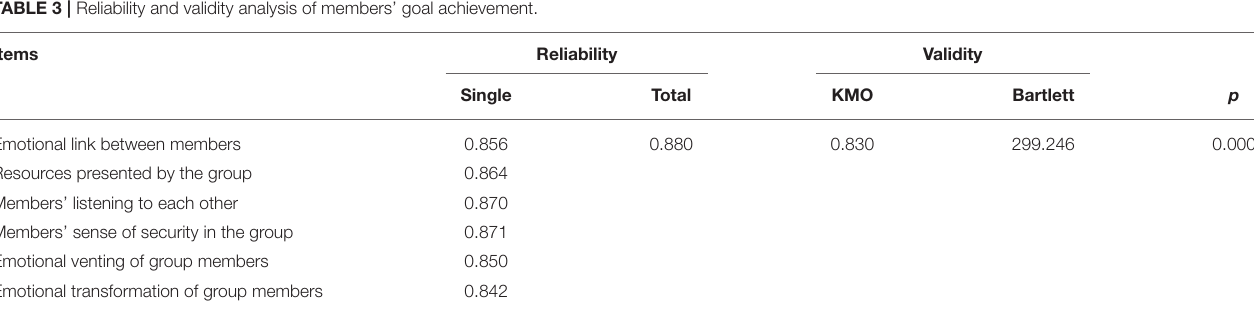
TABLE 3 | Reliability and validity analysis of members’ goal